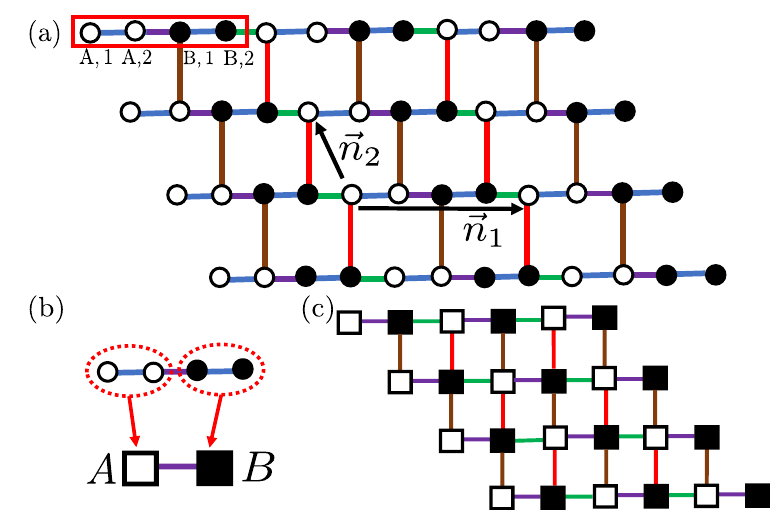
Figure 9: (a) The q = 2 version of the brick-wall lattice in Fig. 5 (a). (b) Combine two sites A , 1 and A , 2 ( B , 1 and B , 2) into a single site A ( B ). (c) The lattice in (a) is transformed into a square lattice via the site combination shown in (b). Here open and solid squares form two sublattices A and B